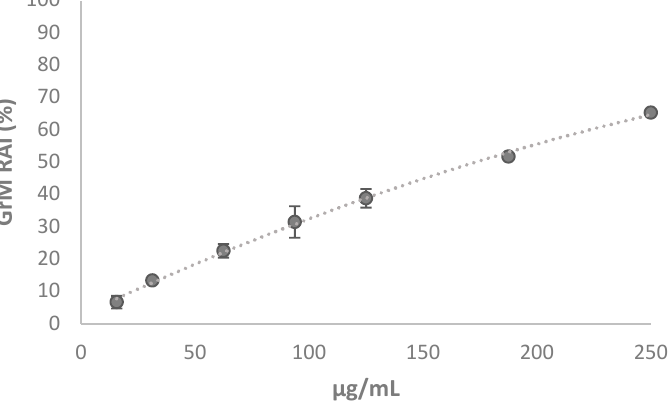
Figure 9. Redox mitochondrial inhibition (RAI%) of GrM extract towards SH-SY5Y cell line at 48 h exposure time. Values are reported as mean ± SD of measurements carried out on 3 samples (n = 3) analyzed 12 times.